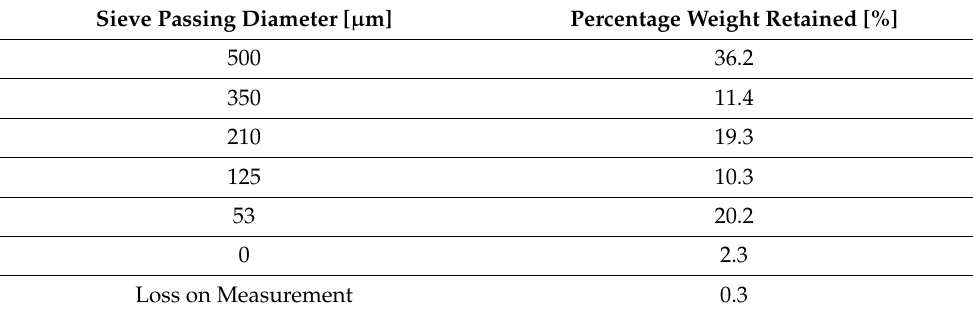
Table 1. Grain size distribution of glass